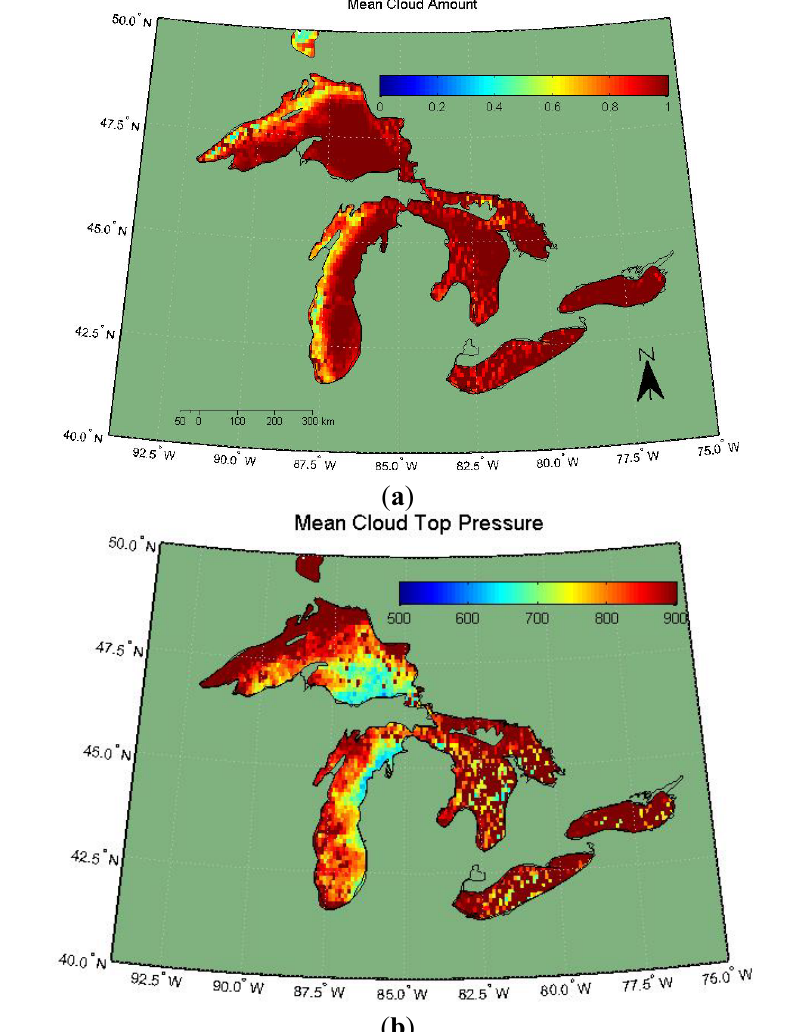
Figure 12. Retrieved cloud properties from MODIS for cases of northwest winds over Lake Superior in winters of 2007 and 2008: ( a ) mean cloud amount; ( b ) mean cloud top pressure in mb; ( c ) mean optical depth for ice cloud; ( d ) effective radius for ice particles in microns and ( e ) mean effective radius of water drops in microns. Land regions are masked as